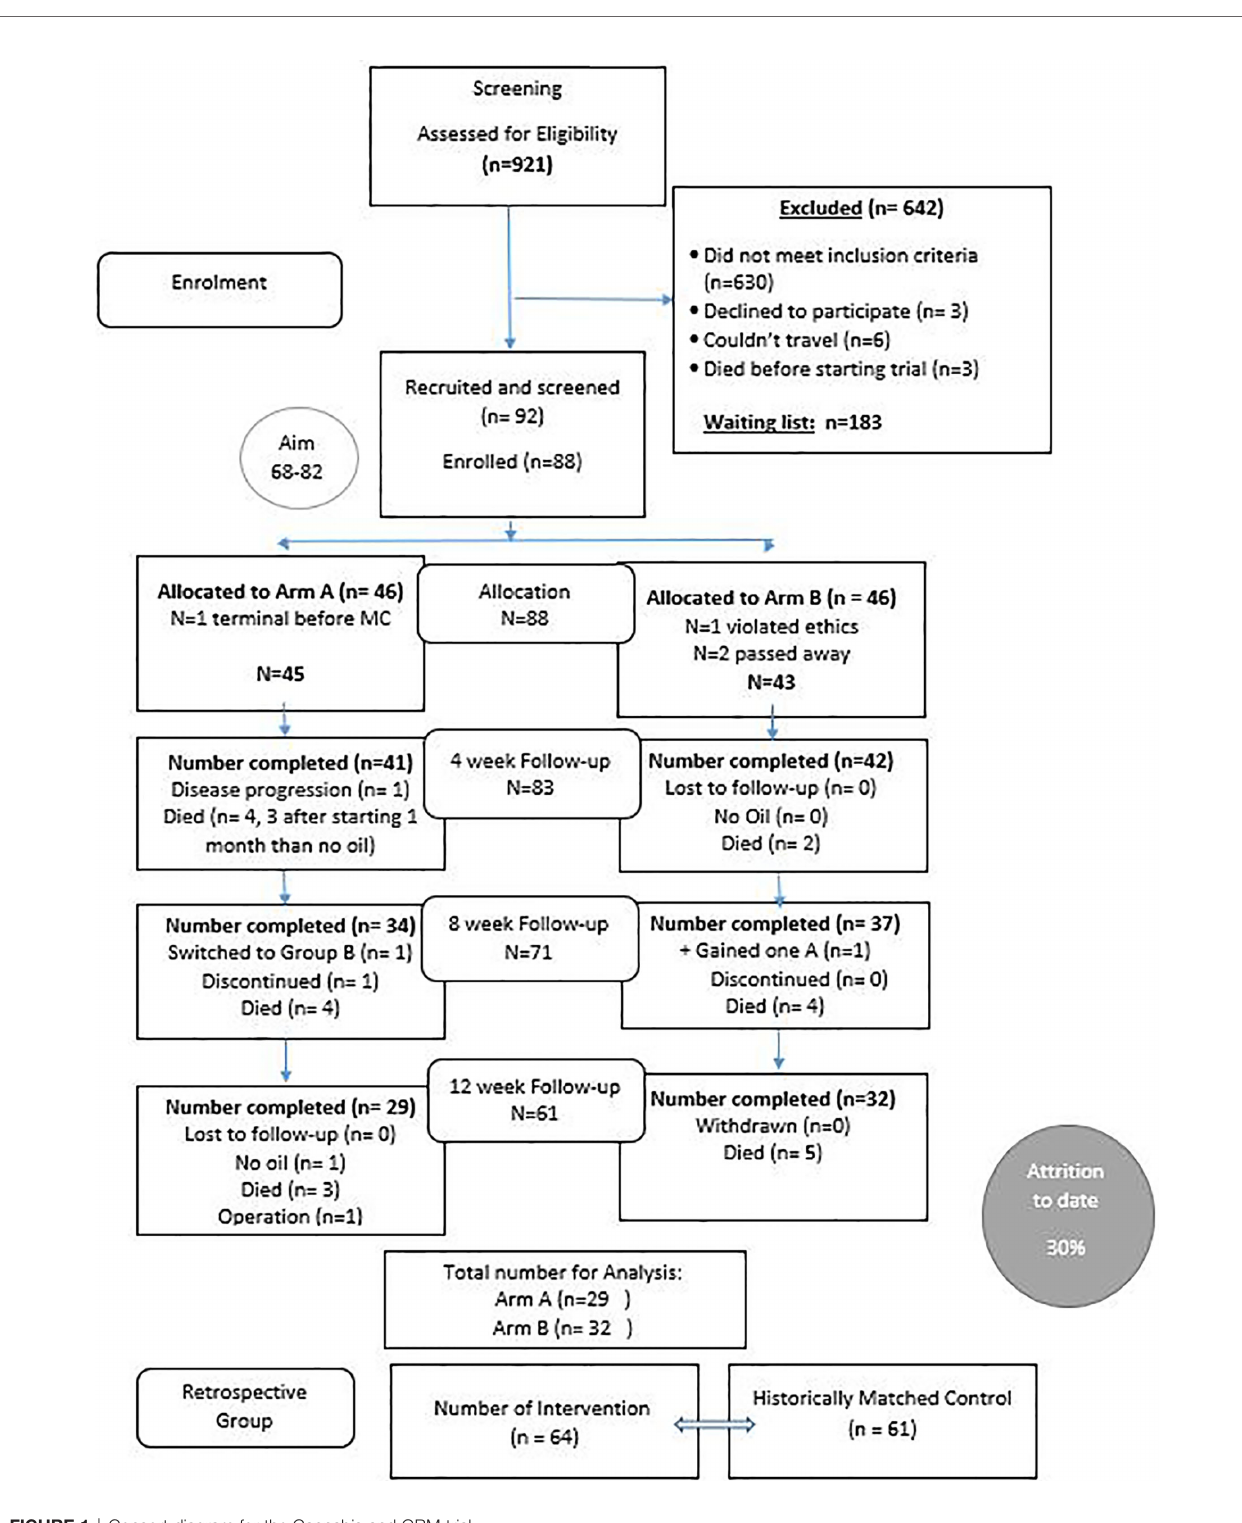
FIGURE 1 | Consort diagram for the Cannabis and GBM